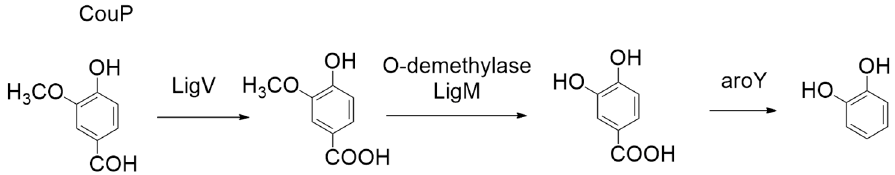
Figure 27. Engineered pathway wired in E. coli to produce catechol from vanillin. CouP = aromatic transporter; LigV = vanillin dehydrogenase; LigM = vanillate-O-demethylase; aroY = protocatechuate decarboxylase. Adapted with permission from [101]. Copyright 2018, Proceedings of the National Academy of Sciences of the United States of America.